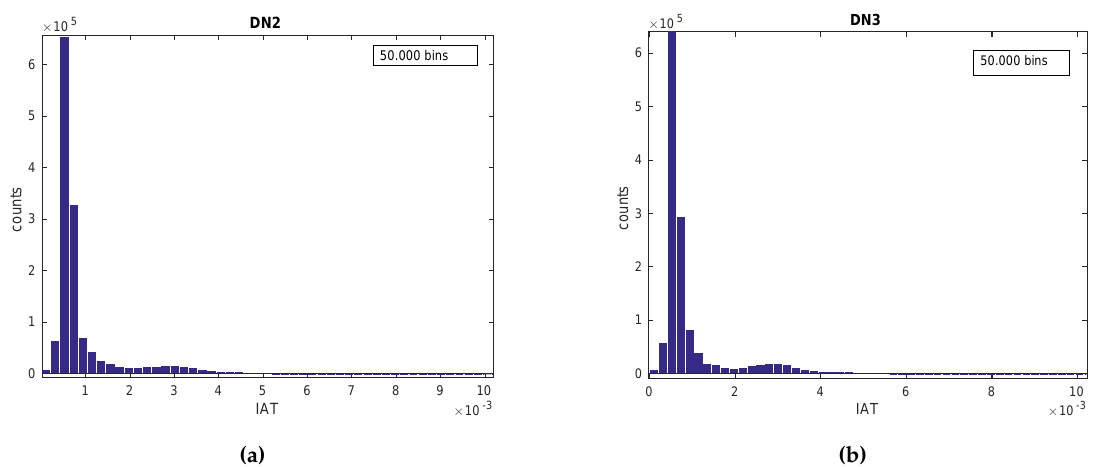
Figure 3. Comparing histograms for DN2 and DN3 for TCP case. ( a ) Histogram of DN2; ( b ) Histogram of DN3.